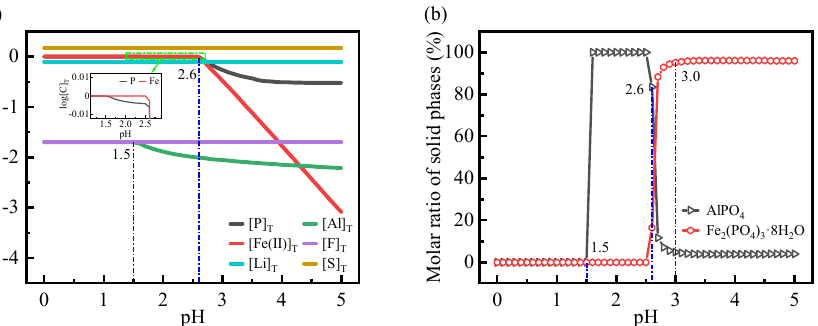
Figure 2. ( a ) Elements equilibrium total concentration and ( b ) solid phases distribution of the Li + –Fe 2+ –Al 3+ –PO 43 − –SO 42 − –F − –H 2 O system (298 K, [P] O = [Fe(II)] O = 1 M, [Li] O = 0.8 M, [S] O = 1.5 M, [Al] O = [F] O = 0.02 M).